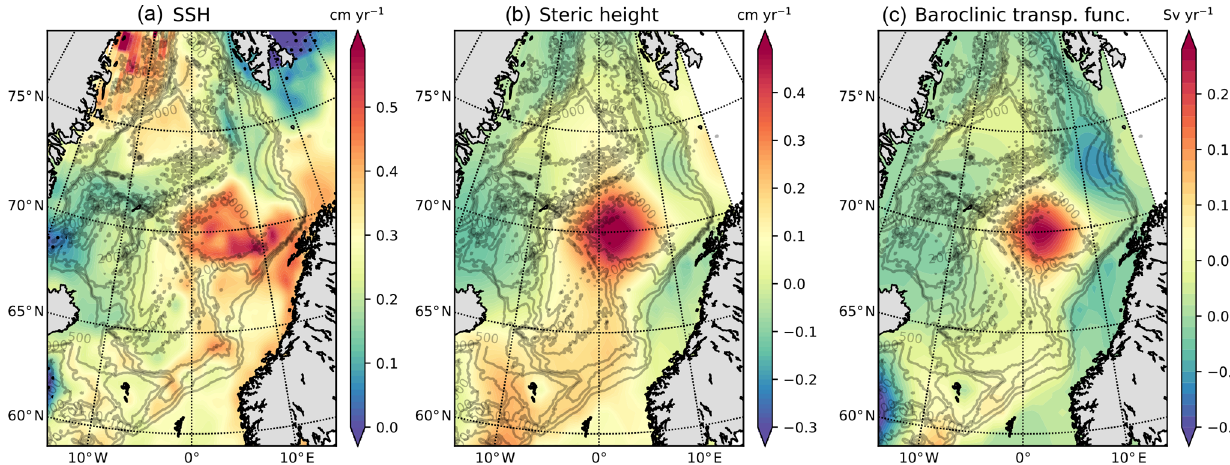
Figure 2. (a) Linear trend in SSH (cmyr − 1 ) over the full altimetry period 1993–2017. (b) Linear trend in steric height (cmyr − 1 ) (see Eq. 1) from 1993 to 2016. (c) Linear trend in baroclinic transport function (Svyr − 1 ; Sv (sverdrup): 10 6 m 3 s − 1 ) (see Eq. 2) from 1993 to 2016. Grey contours are bathymetry (Becker et al., 2009).